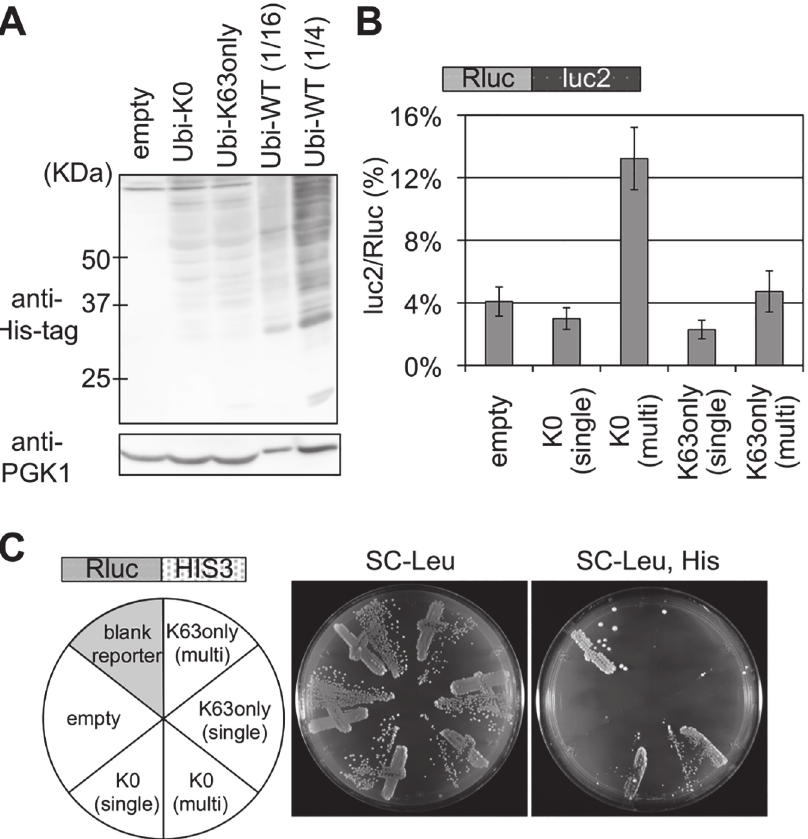
Fig 4. Effects of K0 and K63only ubiquitin mutants on stalled translation. (A) Cellular ubiquitination levels of K0 and K63only ubiquitin mutants. Ubiquitinated proteins were detected as above. Amount of the protein sample from a cell expressing His-tagged wild-type ubiquitin are decreased to 1/16 and 1/4 dilution. (B) Dual luciferase assay for the of K0 and K63only ubiquitin mutants on the Rluc-luc2 reporter. Plasmids bearing K0 or K63only ubiquitin mutants were introduced into a wild-type strain harboring Rluc-luc2 reporter strain (HRKW-2). (single) indicates the transformant with ubiquitin expression from single copy plasmids, and (multi) indicates that from multiple copy plasmids. Average luc2/Rluc ratios and standard deviations were determined from three independent measurements. (C) Genetic colony growth test for the effect of K0 and K63only ubiquitin mutants on the Rluc-HIS3 reporter (SKY24). Types of ubiquitin vectors are indicated on the left. Transformant colonies were streaked on the SC-Leucine (Leu) (middle), and SC-Leucine, Histidine (Leu, His) (right) plates, and colony growth was monitored for 4 days at